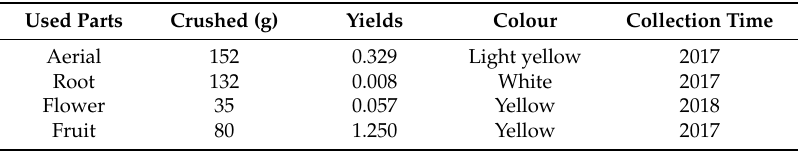
Figure 4. Schematic representation of the main interaction of pimpinellin with BuChE(1-P0I) Green colour represents hydrophobic interactions, light blue represents polar interactions, blue represents positively charged residues, red represents negatively charged residues. Table 3. Zosima absinthifolia Essential oil yields ( w / v ,